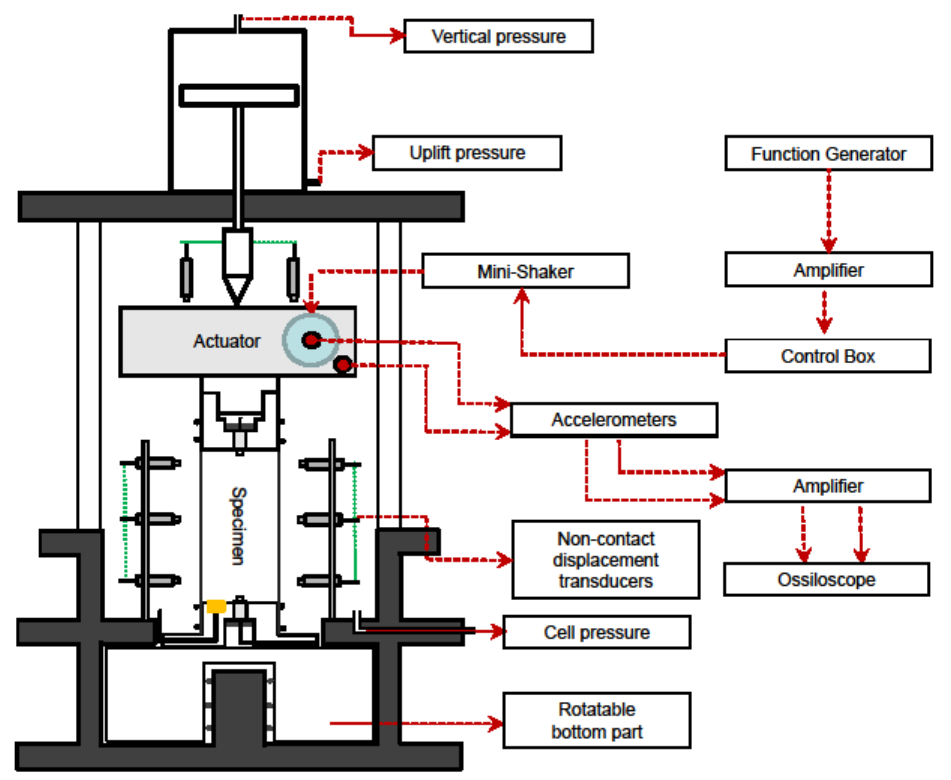
Figure 3. Schematic representation of the RC device used in the present study.